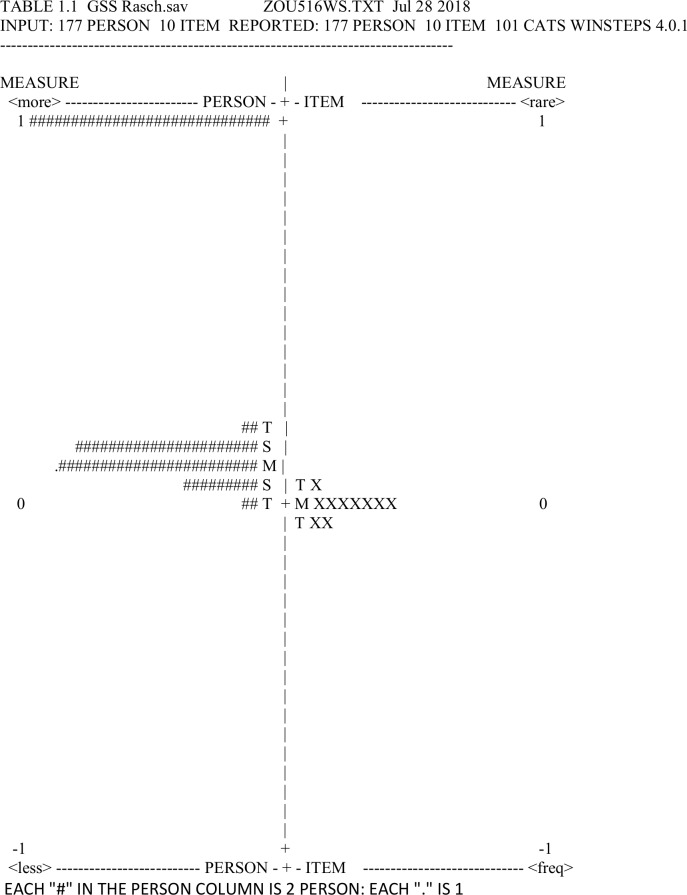
GSS Rasch analysis person item chart.